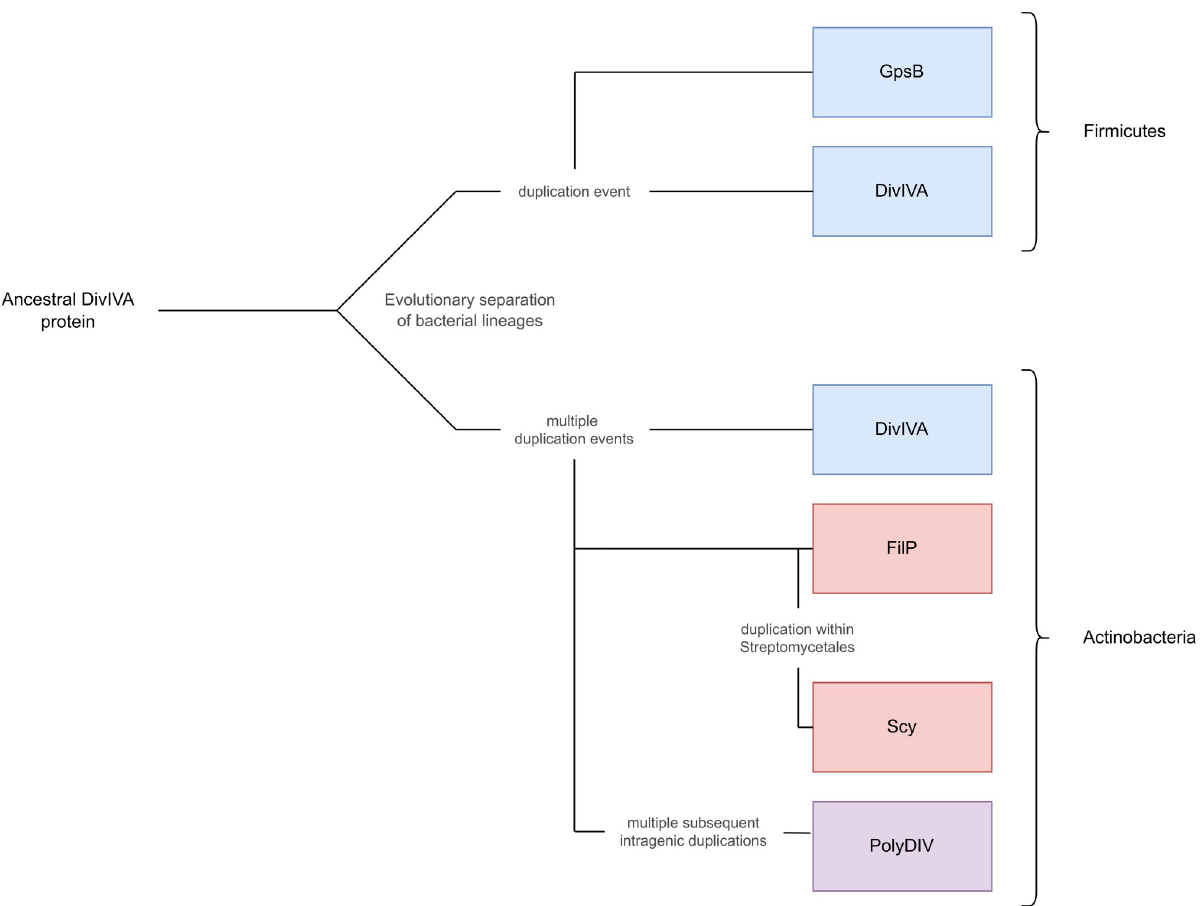
Fig 4. Evolutionary scenario for proteins containing the DivIVA-like domain. The diversity of the DivIVA-like superfamily seems to have arisen mainly through events of duplication (intra- or intergenic) and coiled-coil repeat expansion. The deepest branching point in this tree is an orthologous split due to the separation between Firmicutes and Actinobacteria. All other branch points are due to paralogy.